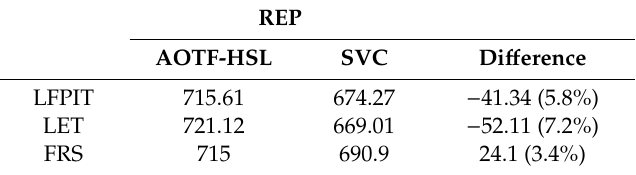
Table 8. The three di ff erent methods’ “Red edge” position results for aloe yellow leaf.